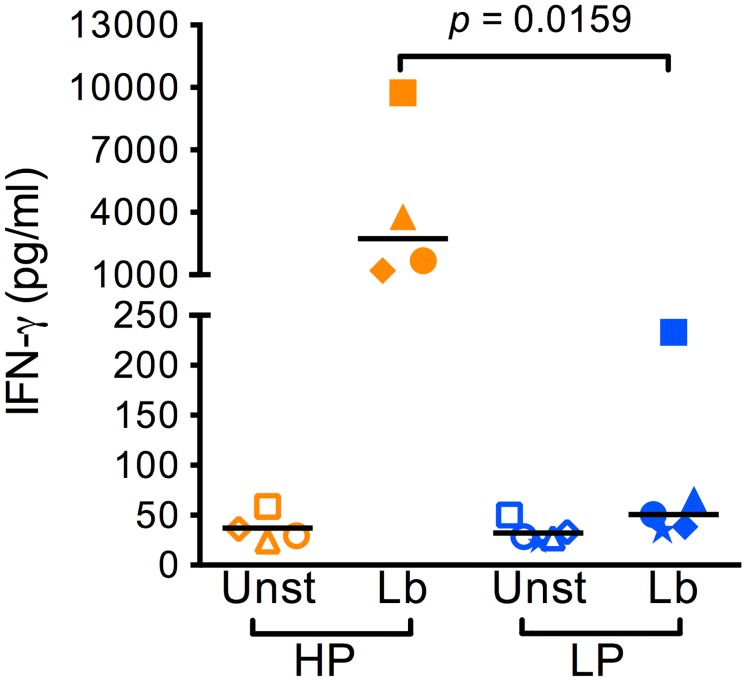
Naïve individuals are High- or Low- IFN-γ producers upon stimulation with Leishmania braziliensis promastigotes.PBMCs were cultured with L. braziliensis for 72h (Lb) or left unstimulated (Unst). Supernatants were collected and IFN-γ levels were determined by ELISA. Data from one representative experiment are shown individually for High Producers (HP) (n = 4) and Low Producers (LP) (n = 5). Samples from three HP (orange) and three LP (blue) individuals, depicted as triangle, diamond and circle were used in subsequent experiments.